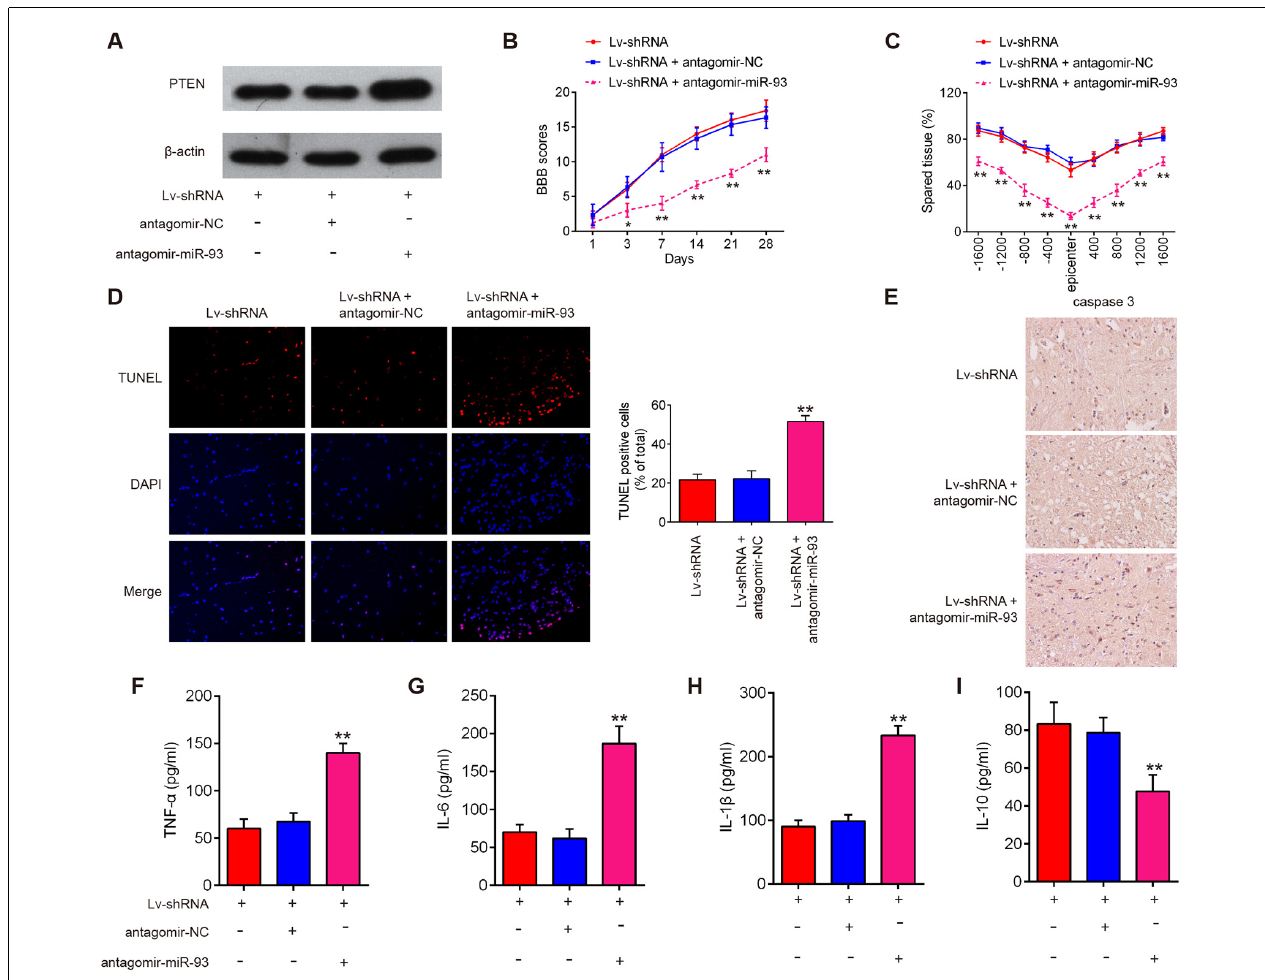
FIGURE 8 | Knockdown of long noncoding RNA (lncRNA) GAS5 improves recovery of spinal cord injury (SCI) mice by regulating the miR-93/phosphatase and tensin homolog (PTEN) axis. The lentivirus vectors lentivirus short-hairpin RNA [LV-shRNA; 105 plaque-forming units (PFU)] and 100 nM antagomiR-93 were injected into the intrathecal space of mice SCI models using a glass micropipette. At the indicated time, the animals were sacrificed and the spinal cord was harvested for further experiments. (A) Expression of PTEN extracts in different groups as measured by Western blotting at 14 days post-SCI. (B) Basso, Beattie, and Bresnahan (BBB) scoring on hindlimb locomotor activity of SCI mice ( n = 10 per group). (C) Lesion analysis at the rostral ( − ) and caudal (+) margins from the lesion epicenter using cresyl violet staining 14 days after SCI (n = 10 per group). (D) Apoptosis determined by terminal deoxynucleotidyl transferase dUTP nick end labeling (TUNEL) assay at 14 days post-SCI. (E) Immunohistochemistry (IHC) analysis of cleaved caspase-3 in spinal cord tissues at 14 days post-SCI. (F–I) Levels of tumor necrosis factor (TNF)- α , interleukin (IL)-6, IL-1 β , and IL-10 in tissue grinding fluid from mice at 3 days post-SCI as measured using enzyme-linked immunosorbent assay ( n = 10 per group). Data represent the mean ± SD of three independent experiments. * p < 0.05, ** p < 0.01 vs. LV-shRNA